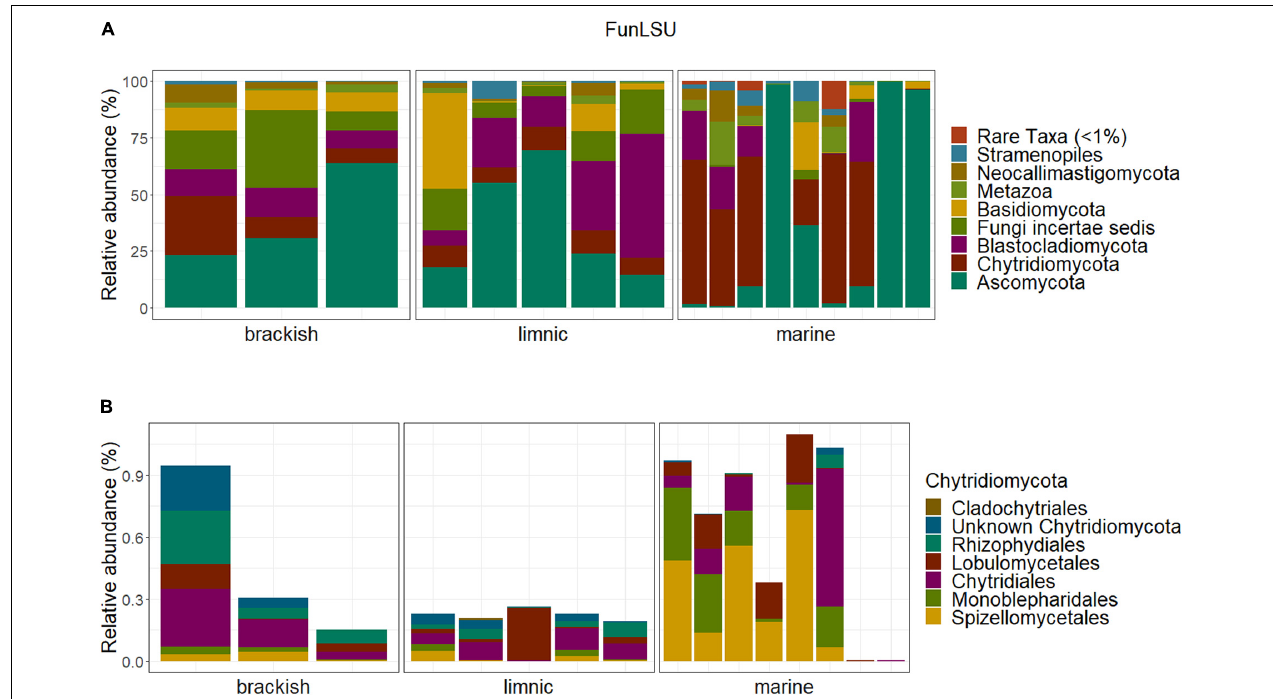
FIGURE 4 | Community composition in the Antarctic benthic habitats, considering the abundance distribution in composition in sampled water types (A) of the whole fungal community (B) and the phylum Chytridiomycota relative to the total fungal